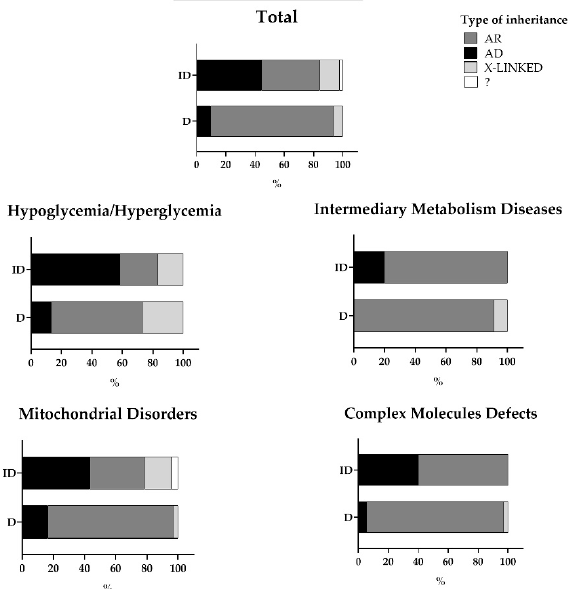
Figure 3. Inheritance pattern for single-gene diseases that were included in each individual panel and identified in successfully and inconclusively diagnosed patients. Abbreviations: ID, inconclu- sive diagnosis; D, diagnosis; AR, autosomal recessive; AD, autosomal dominant; ?, no inheritance pattern identified in the genes included in the genetic